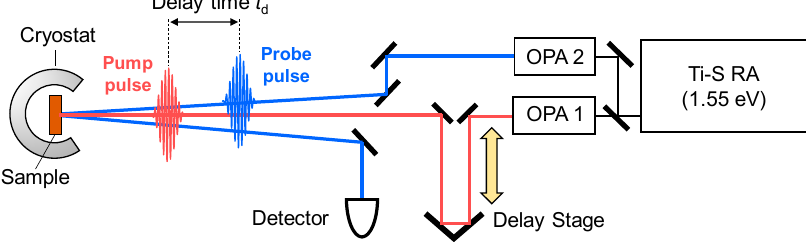
Figure 8. Schematic of optical-pump optical-reflectivity-probe measurement system. Ti-S RA: Ti-sapphire regenerative amplifier; OPA: optical parametric amplifier.